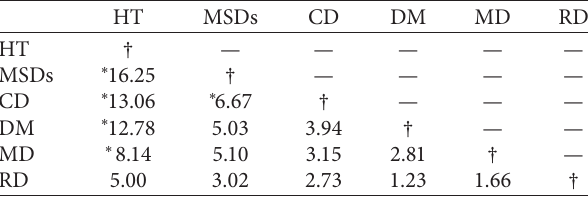
Table 2: Prevalence of the combination of two chronic diseases (SABE study, municipality of São Paulo,